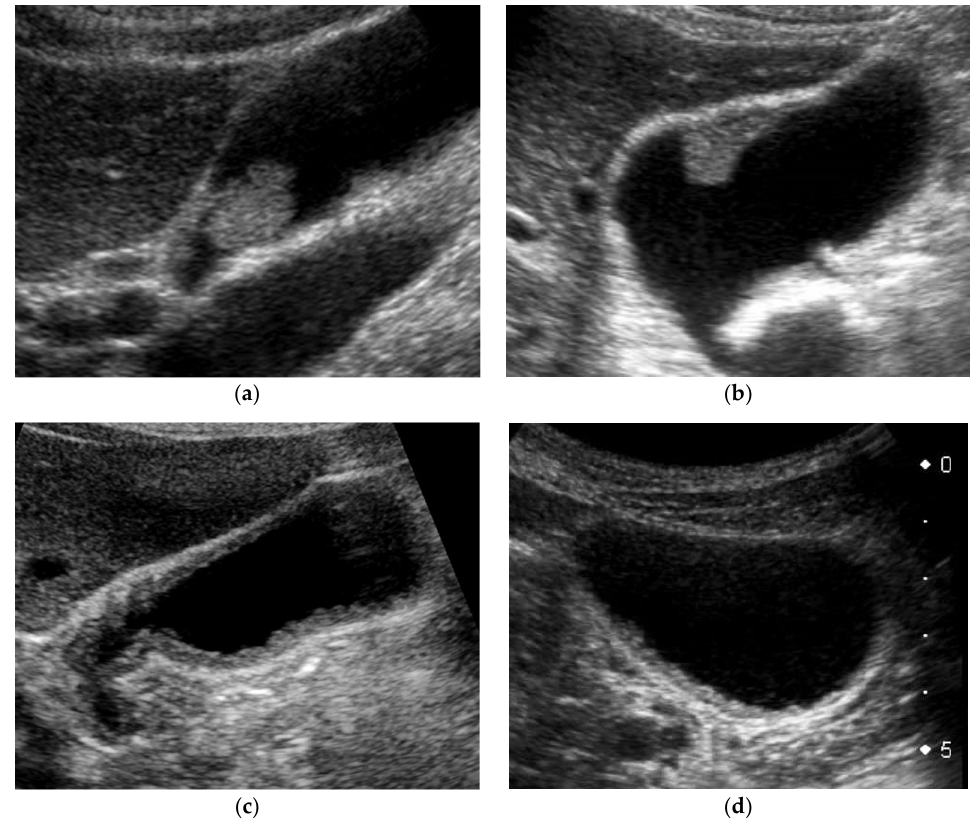
Figure 3. Morphological classification of US appearance. ( a ) Pedunculated GPL, ( b ) sessile (broad- based) GPL, ( c ) diffuse GWT, ( d ) focal GWT (all cases are GBCs).